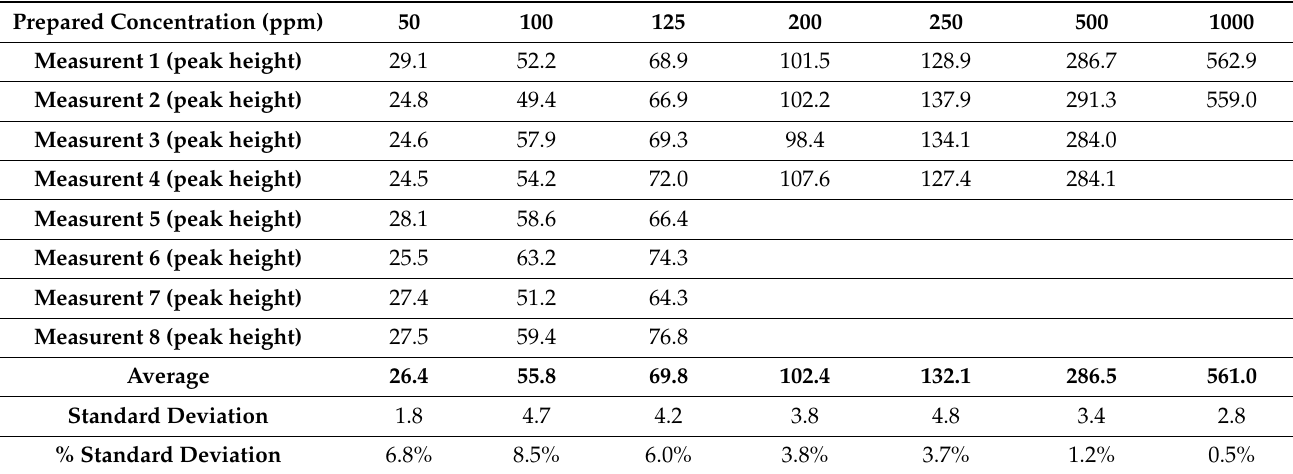
Table 3. Series 2 prepared HCO 3 − concentrations in water containing 2650 ppm sulfate with repeat 1360 cm − 1 peak heights, averages, standard deviation and percent standard